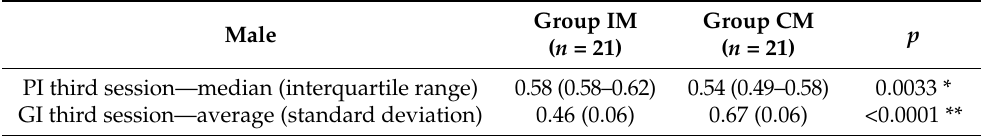
Table 14. Average of PI and GI in the third monitoring session in female patients. Female PI third session—median (interquartile range) 0.58 (0.54–0.62) 0.54 (0.45–0.58) 0.0005 * GI third session—average (standard deviation) 0.46